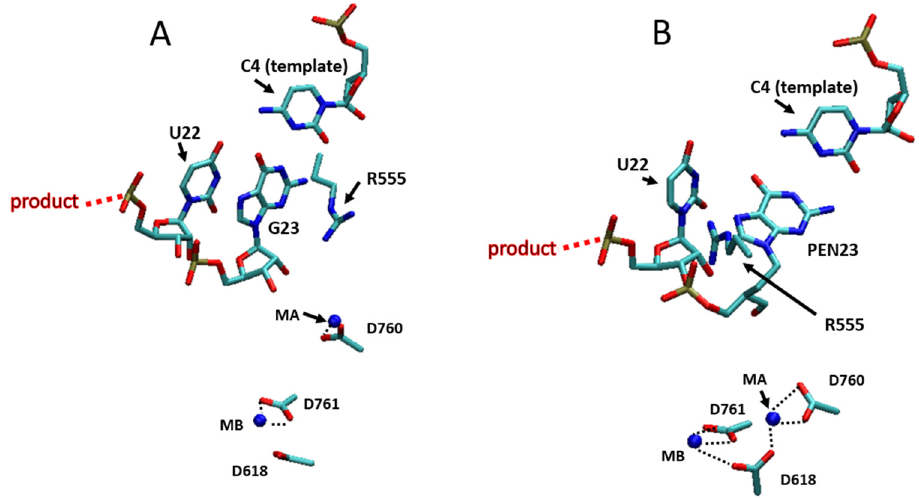
Figure 7. Images of the bases in the template and product strands, ions, and side chain of some amino acids in the active site in the presence of G23 ( A ) and PEN23 ( B ). Images were obtained by VMD software.